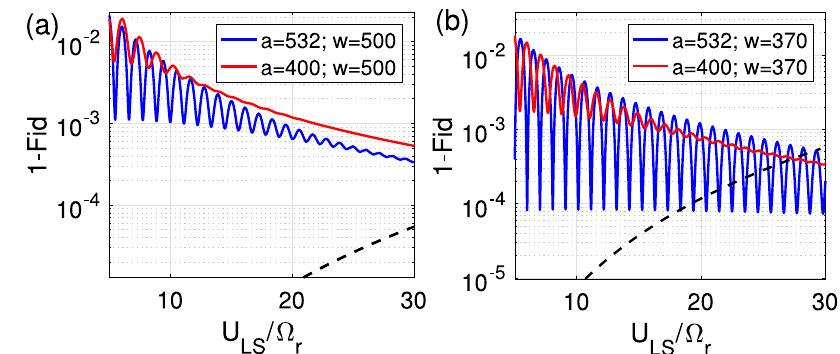
Fig. 9 Single-site addressing — effects of laser cross-talk and misalignment on gate ’ s fi delity. The population that does not return to the qubit basis after gate operation would be considered as loss. The errors are averaged over the laser ’ s misalignment area which is a circle with radius r 0 and also over the Wannier state of atoms. The reported error is averaged over all qubit con fi gurations in a C 4 -NOT gate. Red and blue lines are corresponding to systems described in Fig. 1 and 2 with lattice constants a = 400 and 532 nm. The solid and dashed lines are corresponding to errors of plaquette (cid:1) E p and central . To apply the single-site addressing the 788 nm laser is focused to 1/ e 2 intensity waist of a w = 500 nm and b w = 370 nm with an alignment atoms (cid:1) E c accuracy of r 0 = 25 nm, generating a differential light-shift U LS on 1 j i r h j transition. The Oscillation is due to the change of effective Rabi frequency ~ Ω , which leads to different values of Rydberg leakage at the plaquette sites after the gate operation.